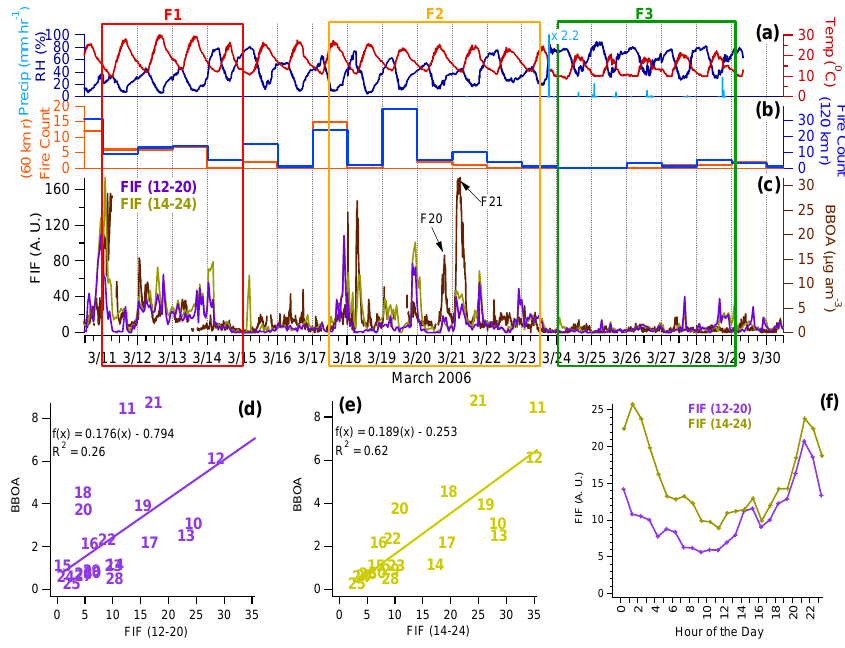
Fig. 3. Time series of (a) ambient temperature and humidity at T0; (b) MODIS fire counts within circles centered in T0 of 60 and 120km radii; (c) FLEXPART Fire Impact Factors (FIF) and AMS BBOA, with fire impact periods (F1, F2, F3) labeled. (d, e) Scatter plot of BBOA Aiken: Version 7 at T0 vs. the two FIF, datapoint symbols are the day of March 2006; (f) Diurnal cycle of the two FIF at T0. Figure 4. Time series of the FIF 14-24 broken down according to the distance from T0 at which the fire emissions took place. Fire impact periods are also marked.